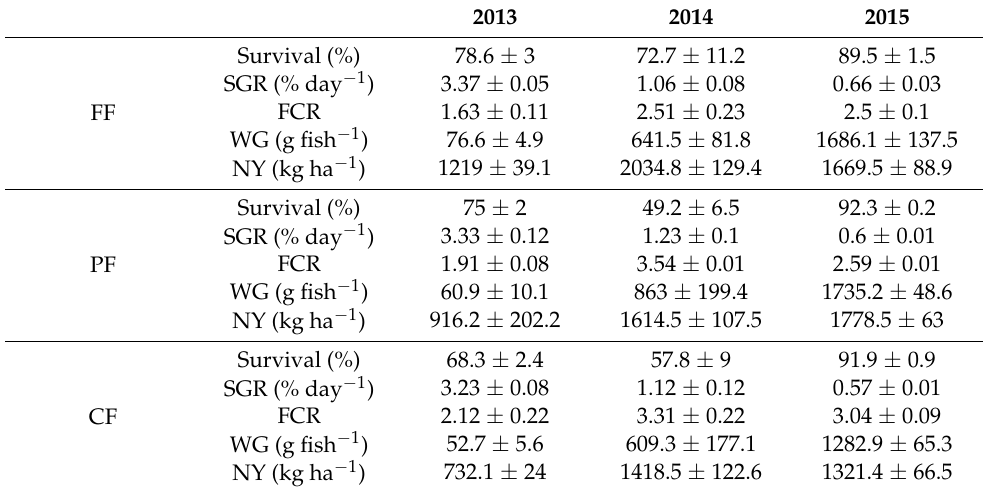
Table 3. Yearly production parameters (mean ± SD) by treatments (FF: feed with fish meal, PF: plant-based feed, CF: cereal